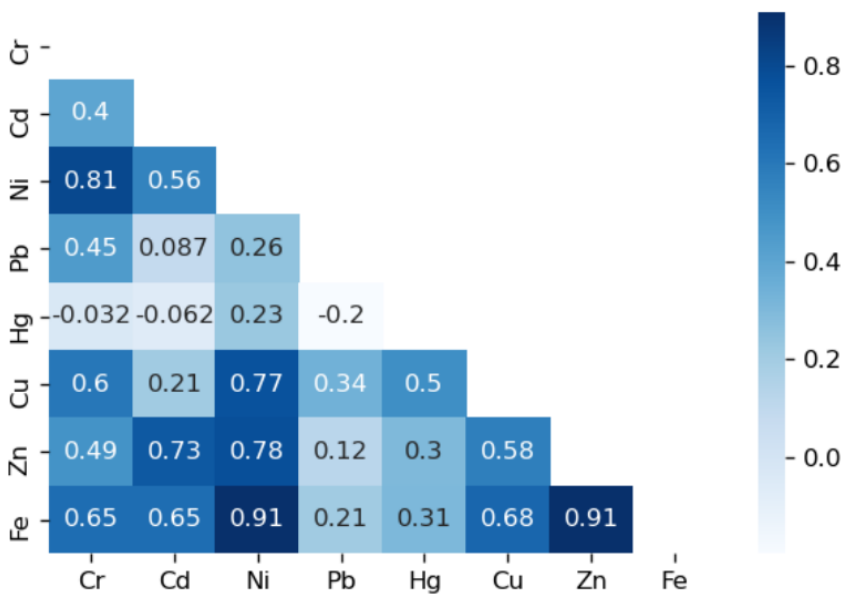
Figure 3. Heatmap of metal correlation coefficients of the sediments of the water bodies in the northern area. n = 56. Correlation coefficients above |0.4| are statistically significant at 0.01 and above |0.3| at 0.05.